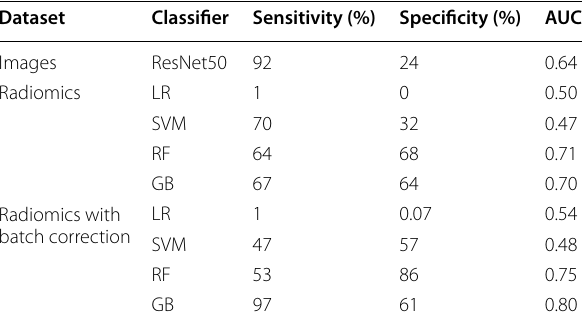
Table 3 Sensitivity, specificity and AUC obtained from previously trained models inferring on the external validation cohort with corresponding data correction